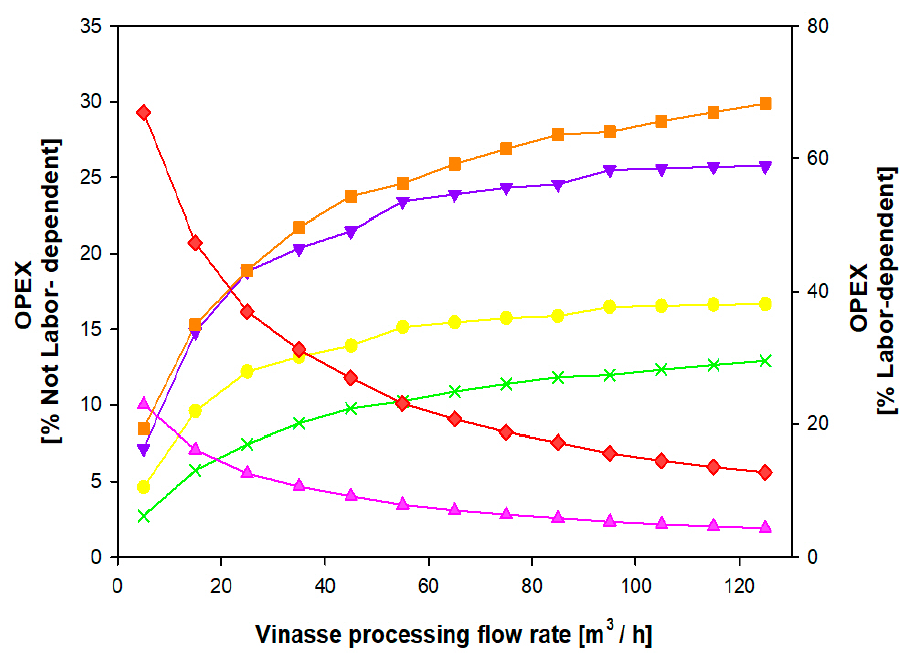
Figure 6. OPEX breakdown as a function of the vinasse processing flow rate. Orange squares: utilities; purple inverted triangles: other facility-dependent; red diamonds: labor-dependent; yellow circles: depreciation; green crosses: raw materials; and pink triangles: laboratory/QC/QA.